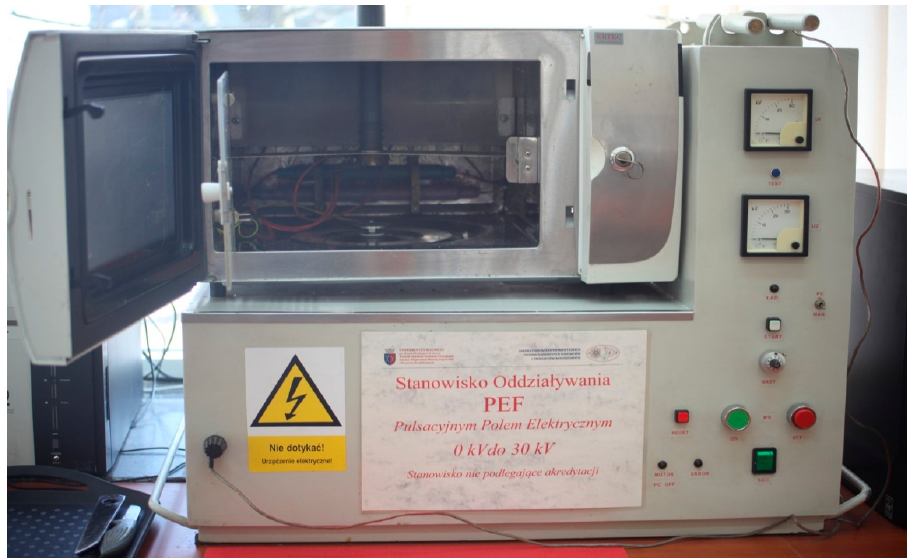
Figure 2. Ertec Su-1 test